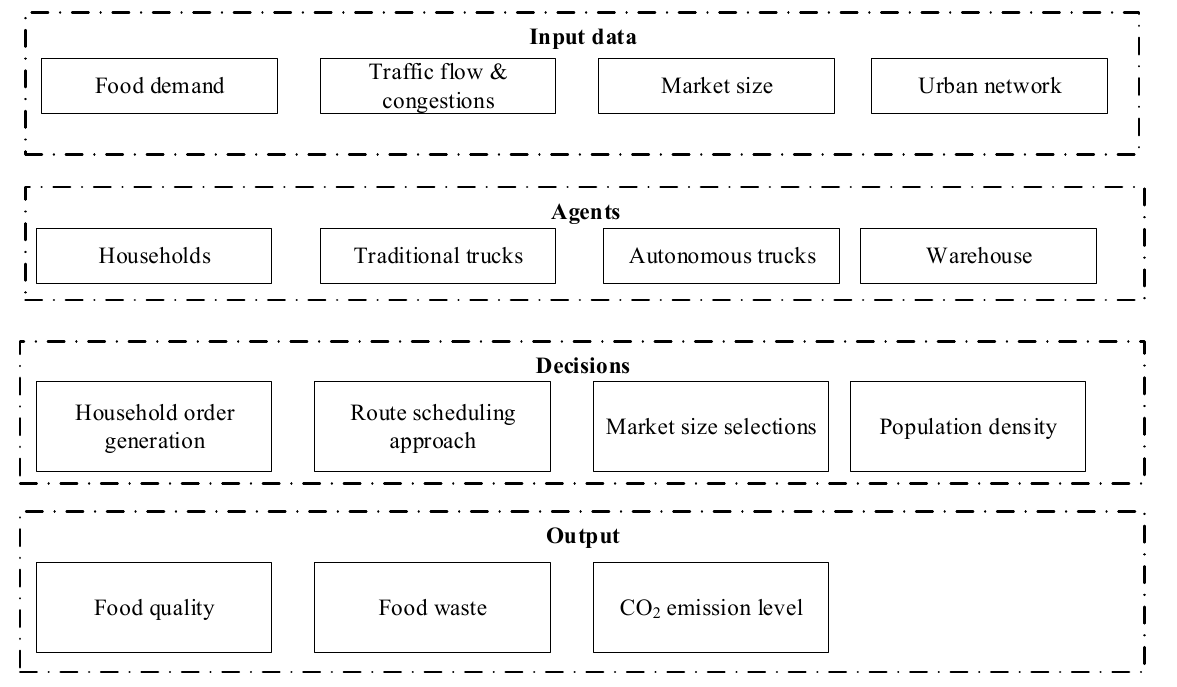
Figure 1. Agent-based modelling approach for information sharing analysis for route scheduling and food quality determination.